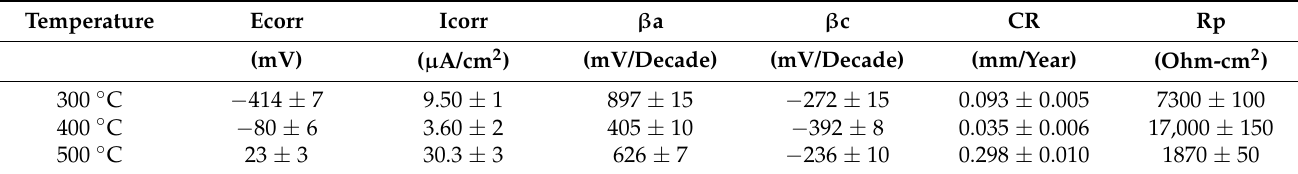
Table 1. Electrochemical parameters of Ni20Cr alloy immersed in Solar Salt at different temperatures.